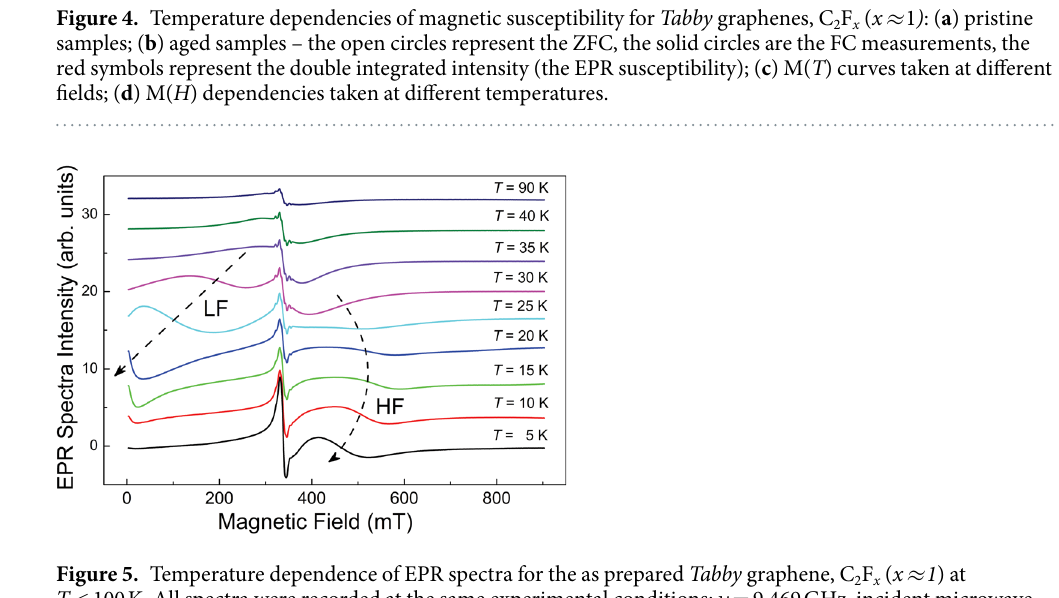
Figure 5. Temperature dependence of EPR spectra for the as prepared Tabby graphene, C 2 F x ( x ≈ 1 ) at T < 100 K. All spectra were recorded at the same experimental conditions: ν = 9.469 GHz, incident microwave power 20 mW, 100 kHz magnetic field modulation amplitude 0.5 mT, and receiver gain 10 4 . The spectra have been shifted vertically for better presentation. The dashed arrows indicate changes in H rbroad for low- and high- field components of the FMR signal at decreasing